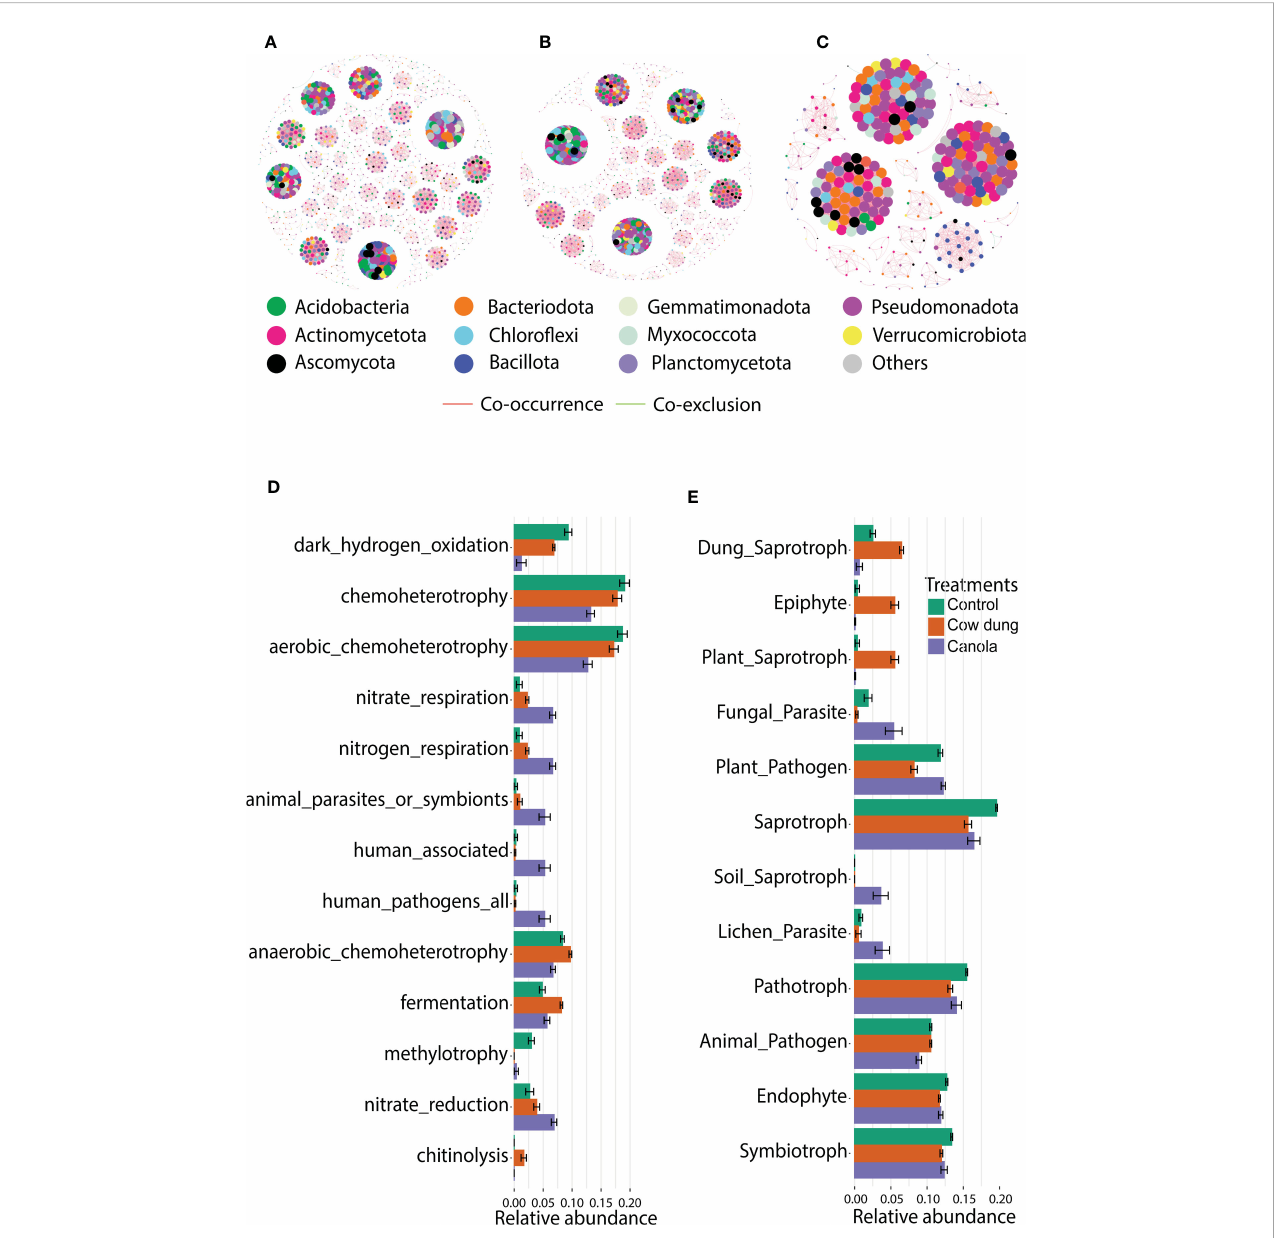
FIGURE 4 Impact of soil amendments on microbial co-occurrence network patterns and functional diversity. Co-occurrence networks of bacterial and fungal communities in treatments based on RMT analysis at the ASV level (Spearman ’ s rank correlation (corr_cut = 0.7), p< 0.05): control (A) , cow dung (B) and canola (C) . Node size in each treatment is proportional to the degree. Predicted functions of bacterial (D) and fungal communities (E) in different treatments based on the FAPROTAX database and fungal guild tools, respectively. LEfSe analysis (LDA score > 4.0) showed differentially enriched predicted functions across